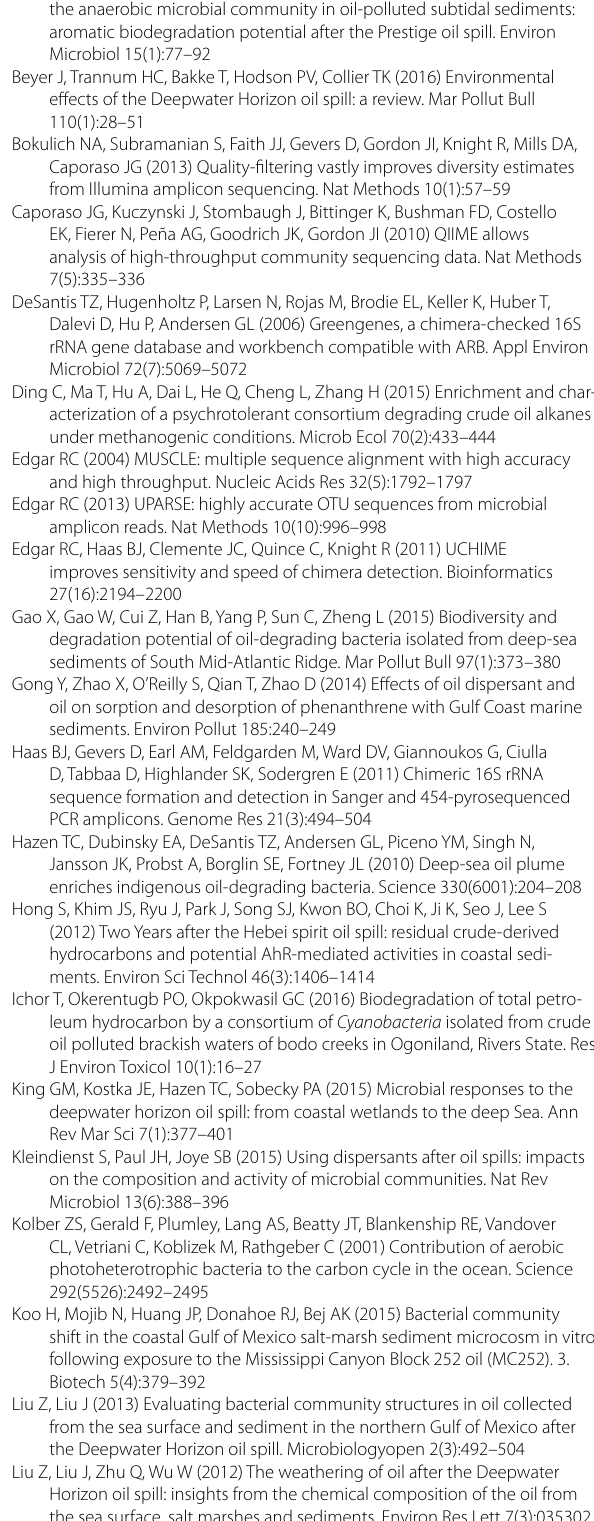
Additional file 1: Figure S1. PCA results of the sampling sediments. Figure S2. The standard curve of the biotoxicity